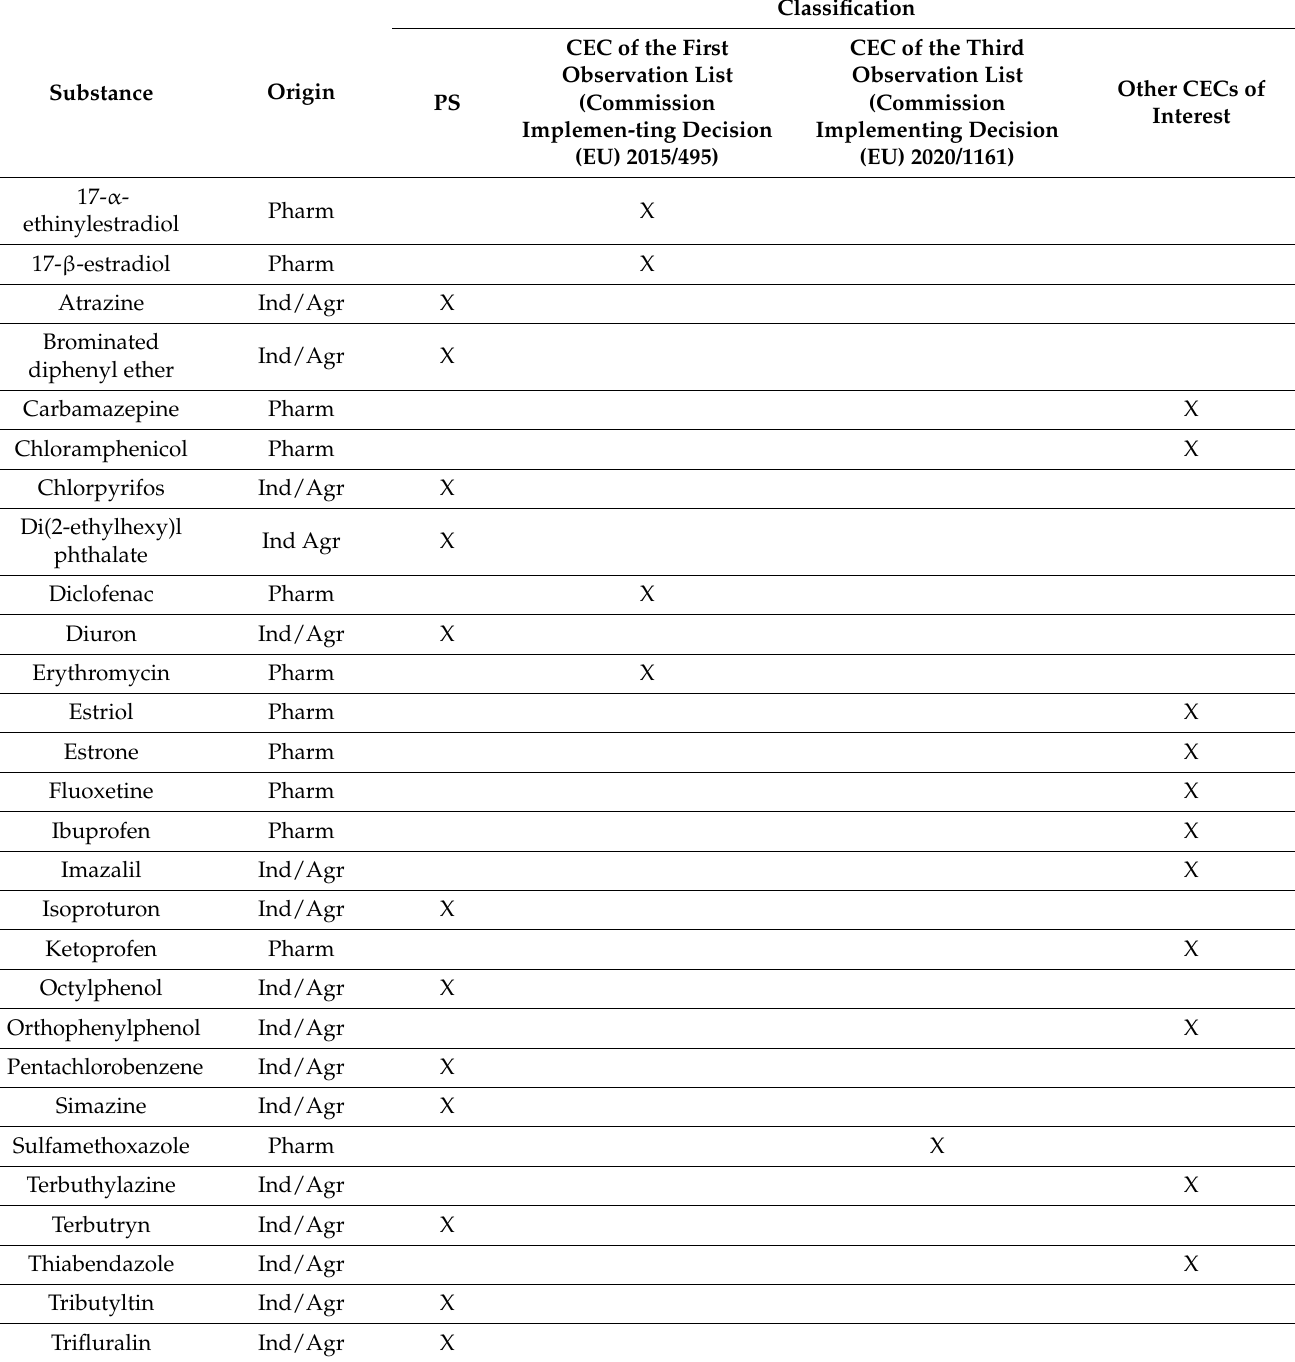
Table 1. Selected